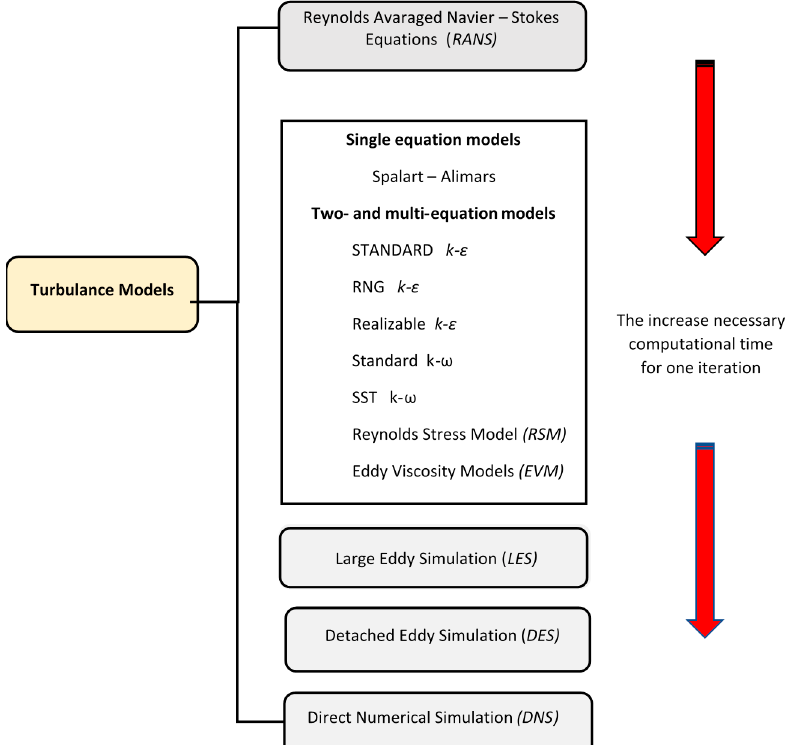
Figure 5. Turbulence models classification.